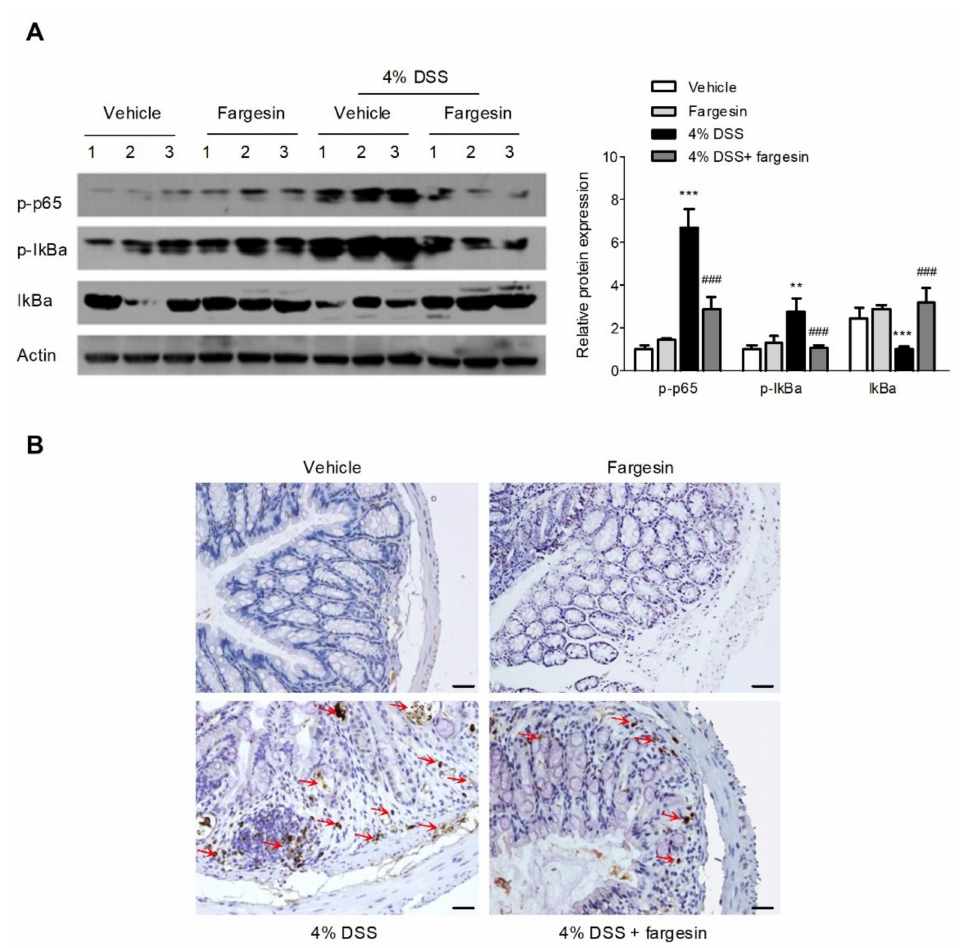
Figure 4. Fargesin inhibited the activation of NF- κ B in vivo. ( A ) Protein levels were determined by immunoblotting using p-p65 (1:1000), p-I κ B α (1:1000) and I κ B α (1:1000) antibodies. One representative experiment is shown. Data were expressed as the mean ± SD of two independent experiments with samples in triplicate. Quantification of the protein expression was performed by densitometric analysis of the blots. ( B ) Representative images of p-p65 immunostaining in colon tissue. Scale bar corresponds to 100 µ m ** p < 0.01, *** p < 0.001 vs. vehicle-treated group; ### p < 0.001 vs. DSS-treated